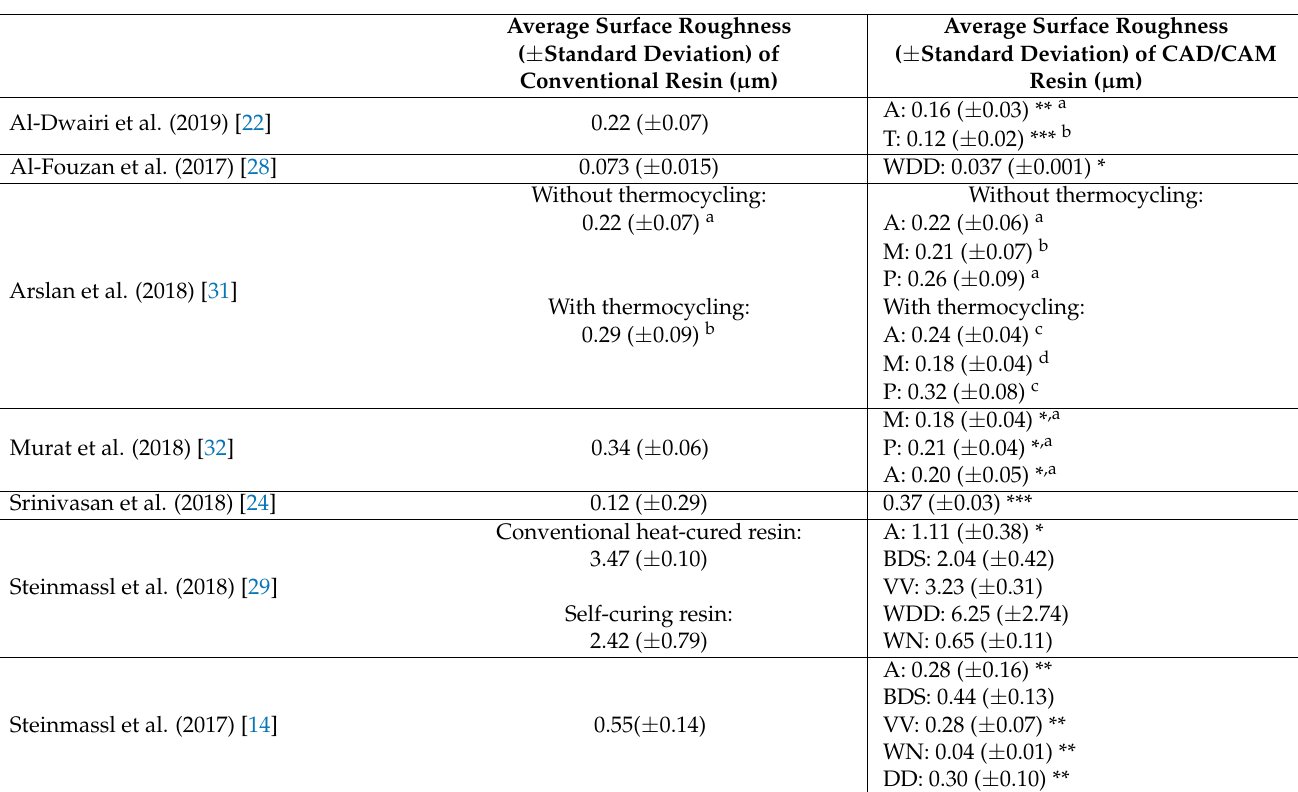
Table 4. Surface roughness test results.